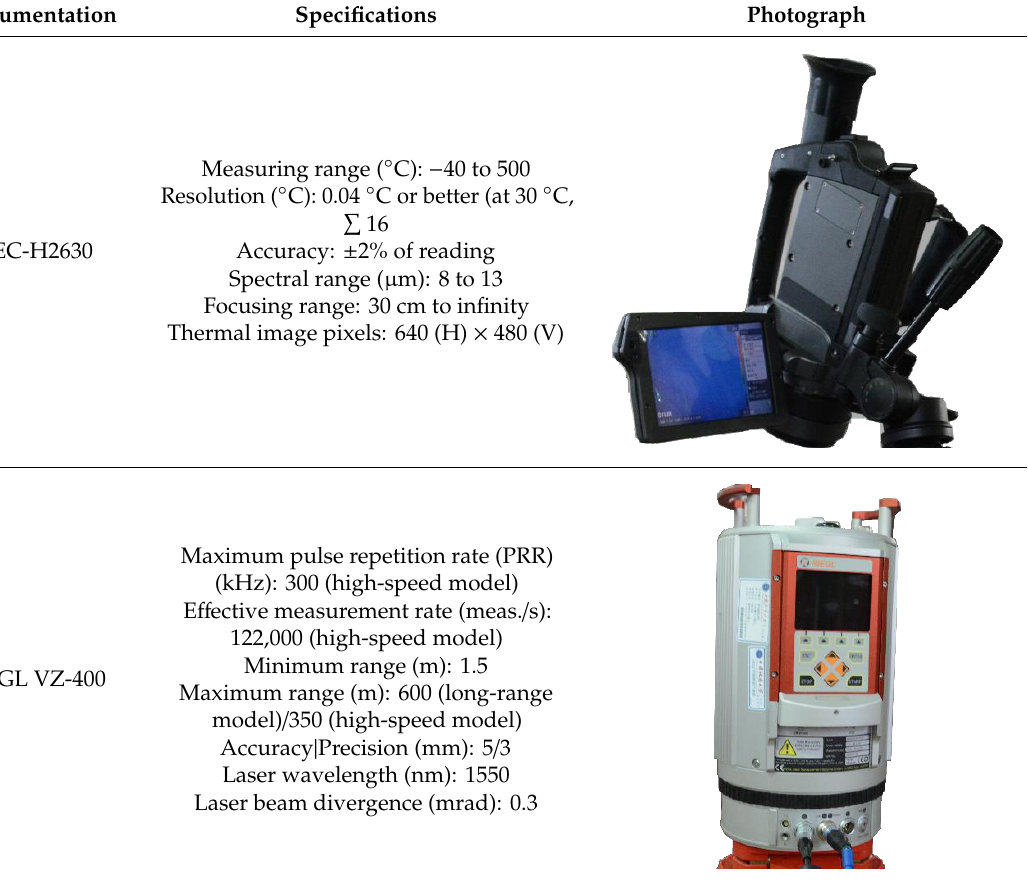
Table 2. Main features of t he instrumentation monitoring units.